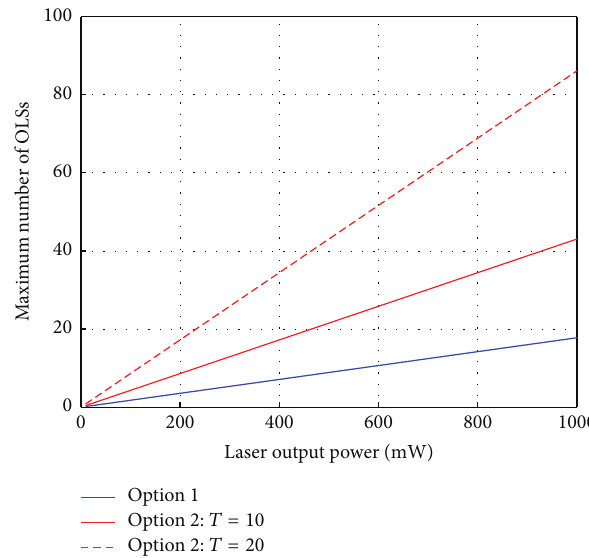
Figure 7: Maximum number of OLSs powered simultaneously ( 𝑁 OLS